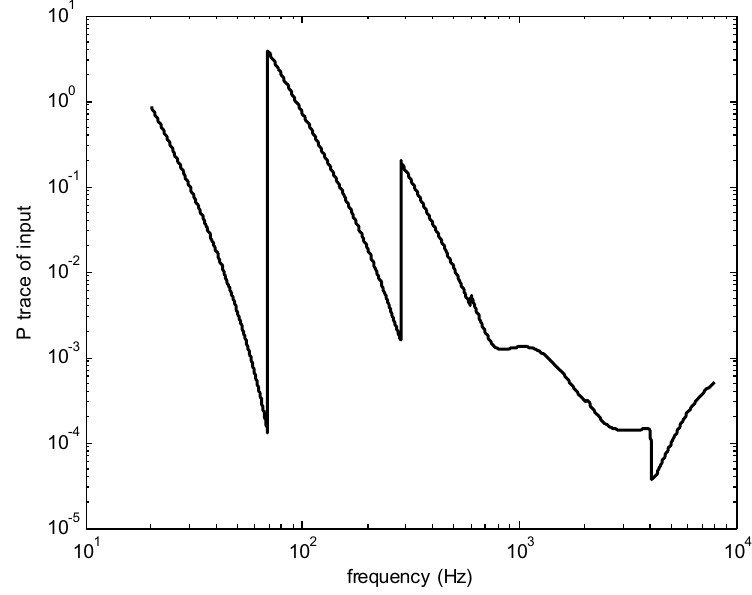
Fig. 22. Trace of the input spectra for the cantilever beam example.